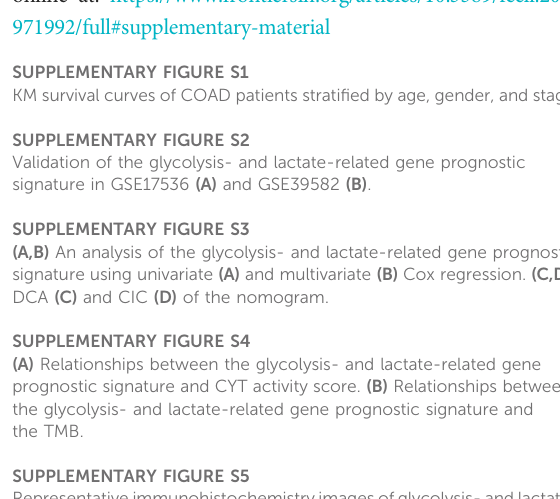
SUPPLEMENTARY FIGURE S1 KM survival curves of COAD patients strati fi ed by age, gender, and stage. SUPPLEMENTARY FIGURE S2 Validation of the glycolysis- and lactate-related gene prognostic signature in GSE17536 (A) and GSE39582 (B) .